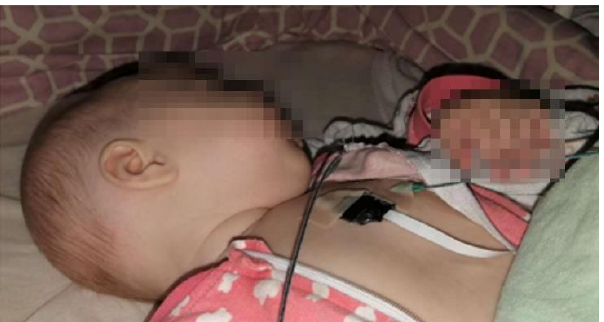
Figure 2. Measurement setup for small children and infants [20]. The accelerometer was placed on the chest of the subjects after they fell asleep. As some subjects moved in their sleep, they induced motion artefacts to the recorded signals.